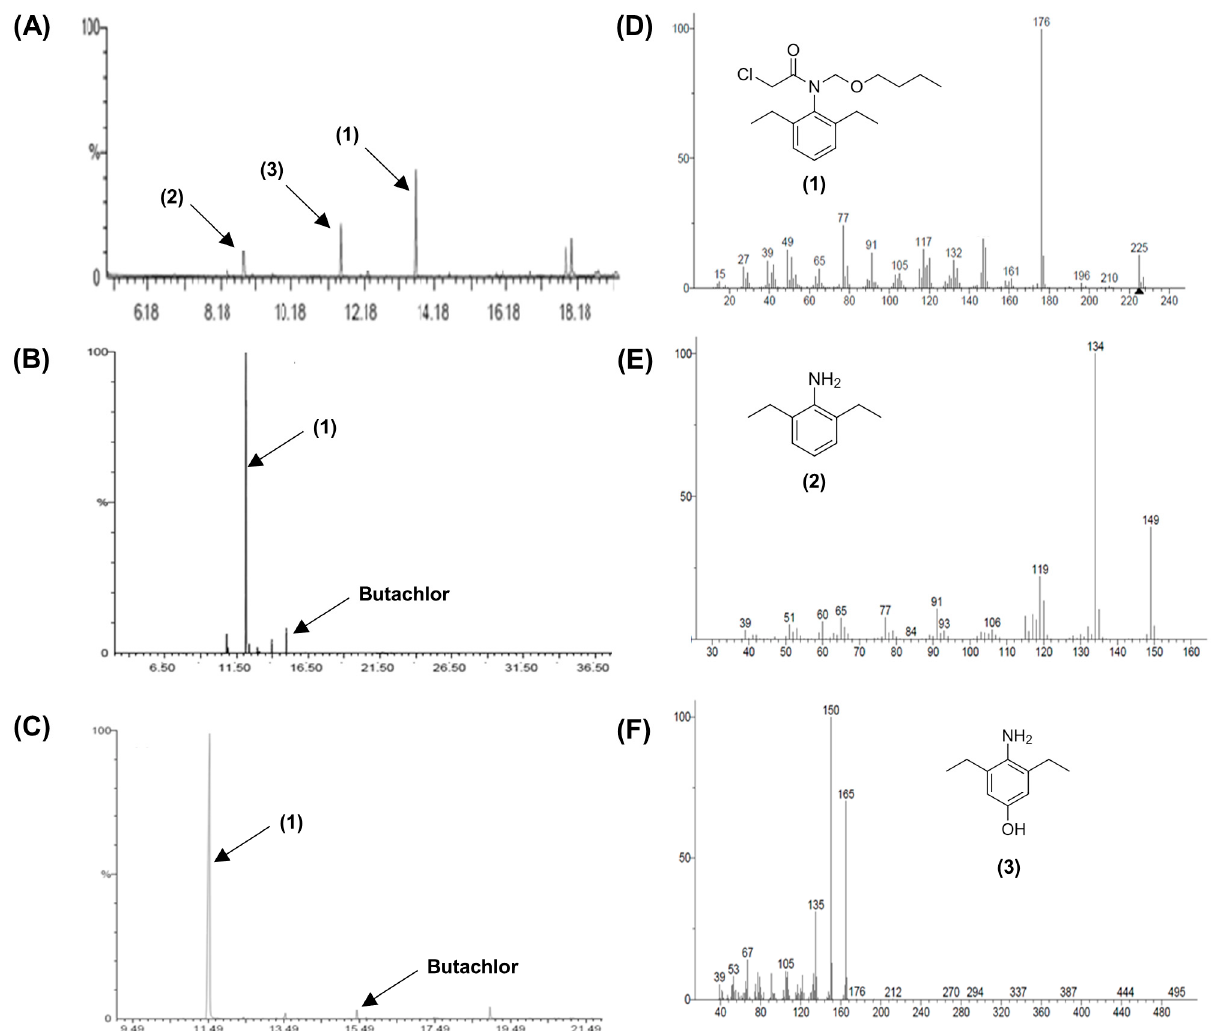
Figure 3. GC profiles and mass spectra of metabolite: ( A ) GC profile of butachlor metabolites produced by O4ab pair; ( B ) GC profile of butachlor metabolites produced by G4-2; ( C ) GC profile of butachlor metabolites produced by O18; ( D ) GC-MS spectra of butachlor metabolites 2-chloro- N - (2,6-diethylphenyl) acetamide (1); ( E ) GC-MS spectra of butachlor metabolites 2,6-diethylaniline (2); ( F ) GC-MS spectra of butachlor metabolites 4-amino-3,5-diethyl phenol (3). Table 2. Degradation and growth of the isolates on various potential intermediates of butachlor. Characteristics